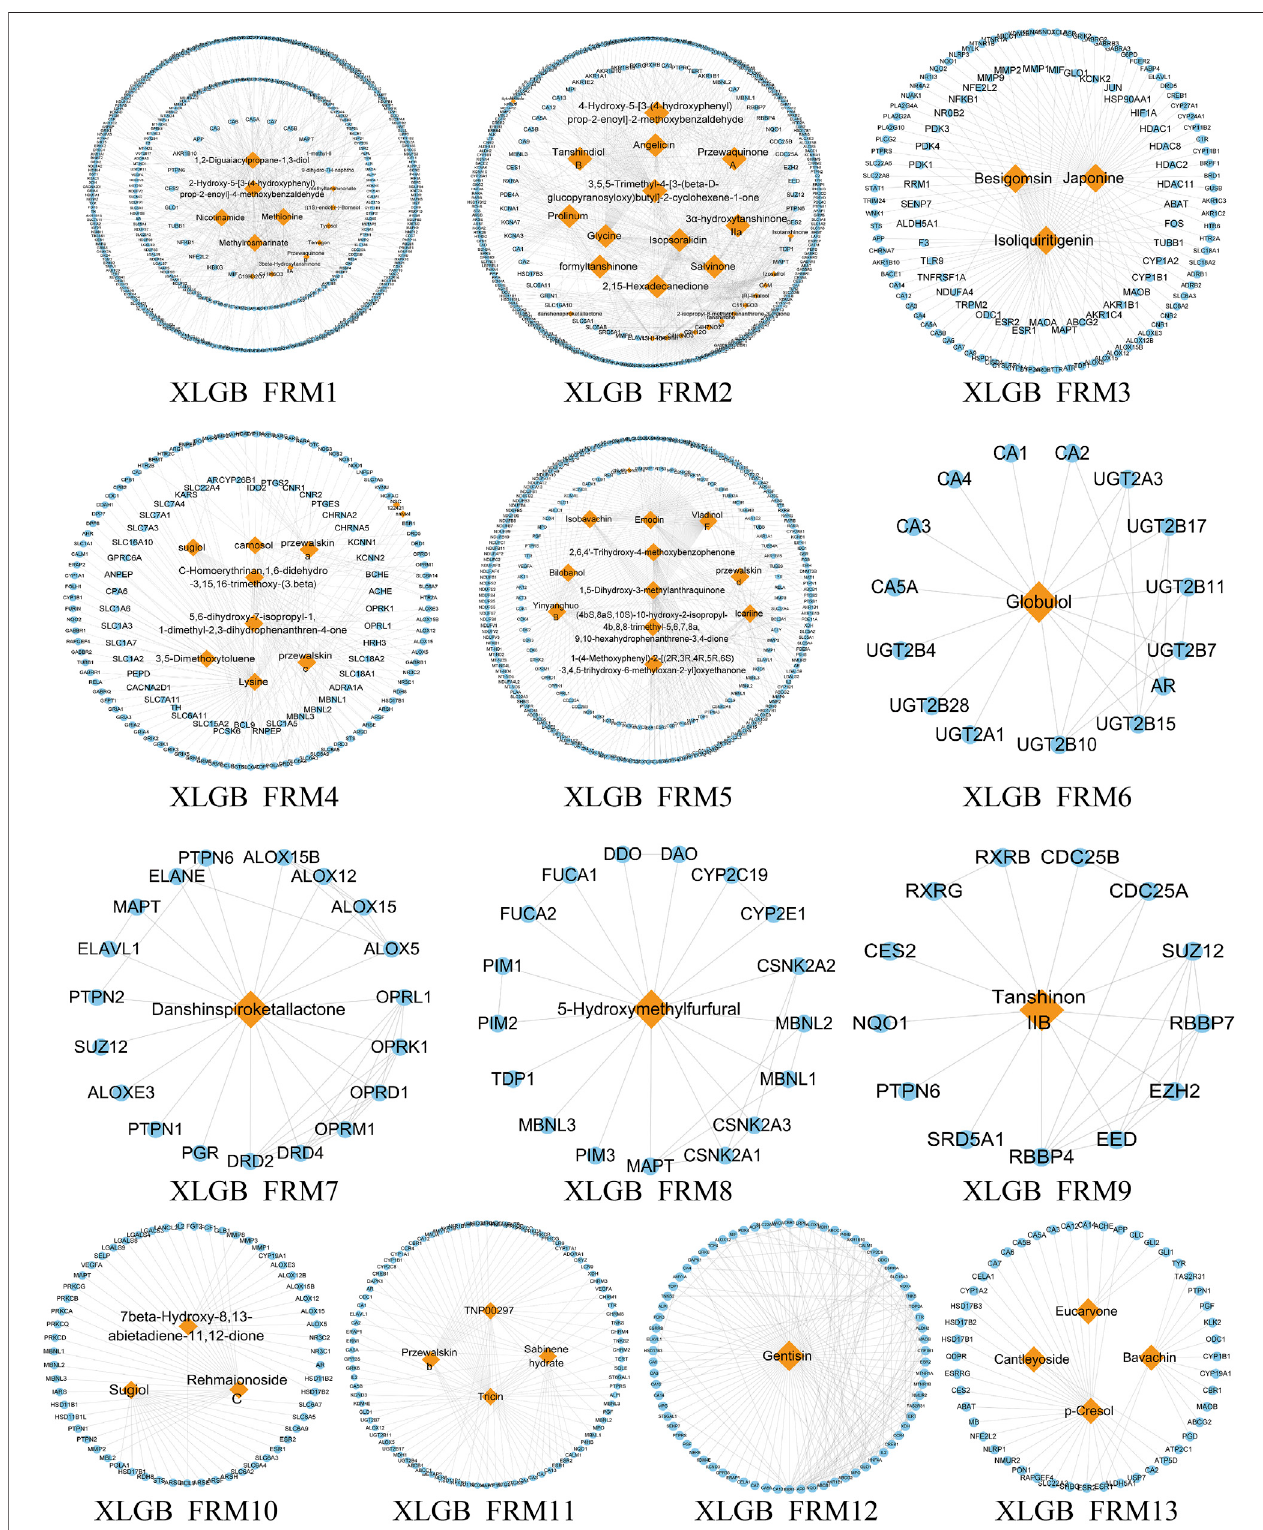
FIGURE 4 | The predicated FRMs of the C-T network in XLGB. The orange nodes represent the components in XLGB, and the blue nodes represent the related targets.